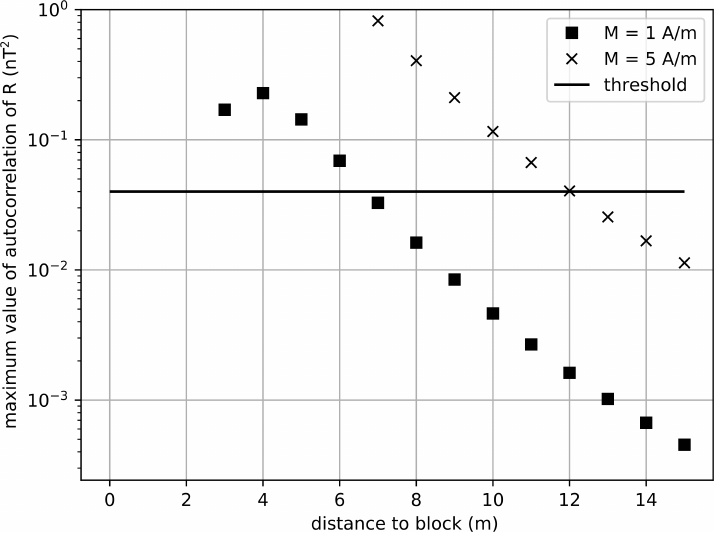
Figure 4. Maximum value of the autocorrelation of R with increasing distance to the magnetized block with a magnetization of 1 A/m (squares) and 5 A/m (crosses). The distance to the block corresponds to the length of R . The horizontal line indicates the resolution of the